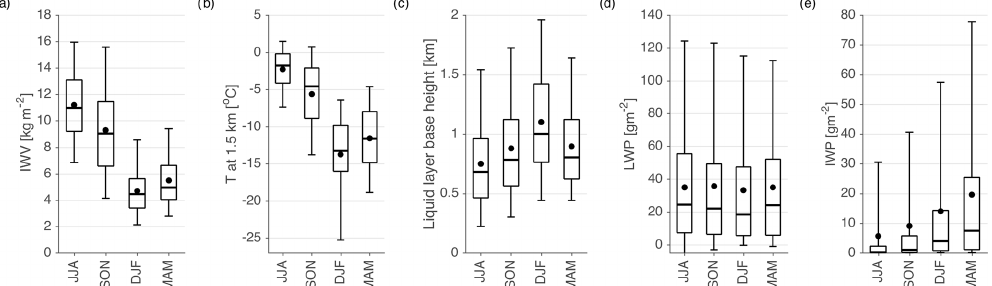
Figure 9. IWV (a) , 1.5km temperature (b) , liquid base height (c) , LWP (d) , and IWP (e) distributions for each season. Only time periods with P-MPCs present are included. Boxes and whiskers as in Fig. 7; the medians were found to differ on a 95% confident level.